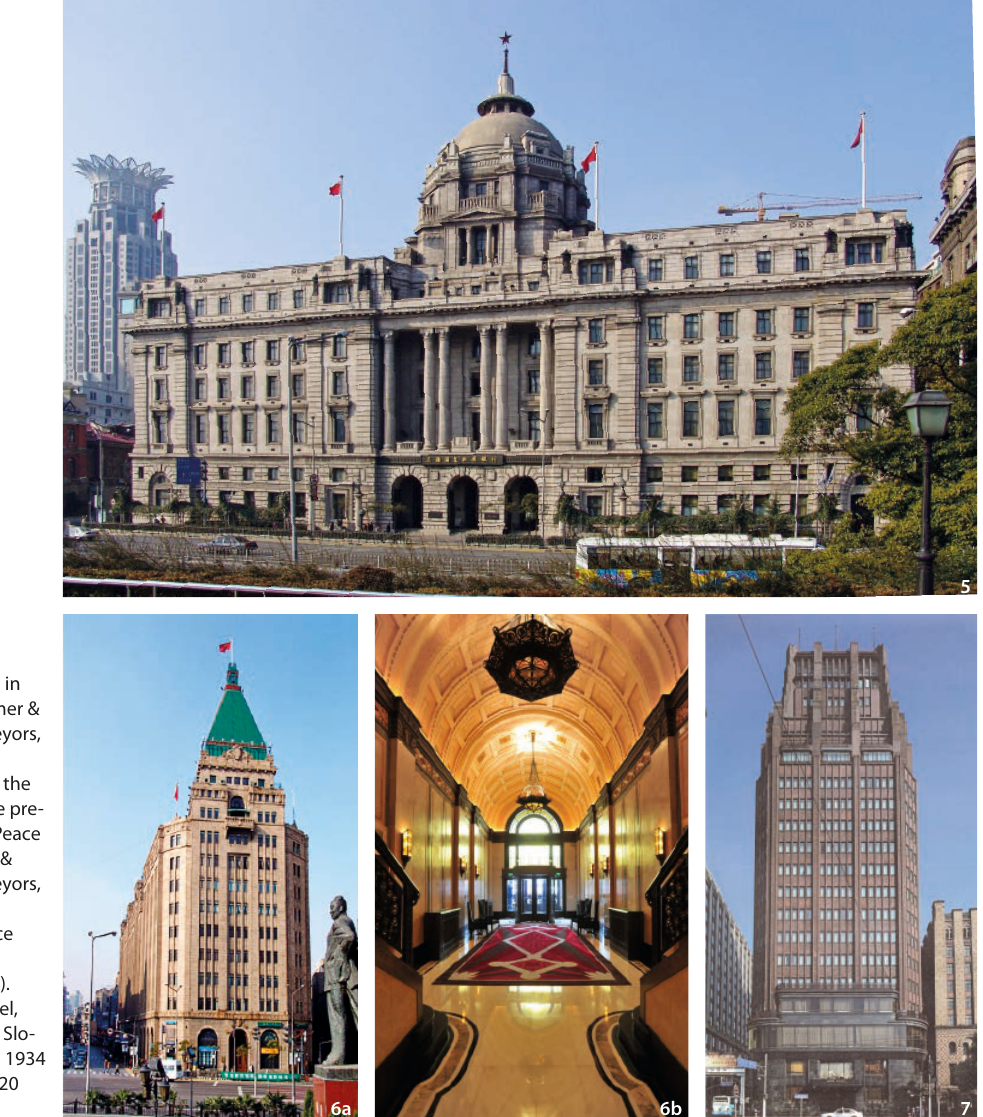
Figure 6b The main